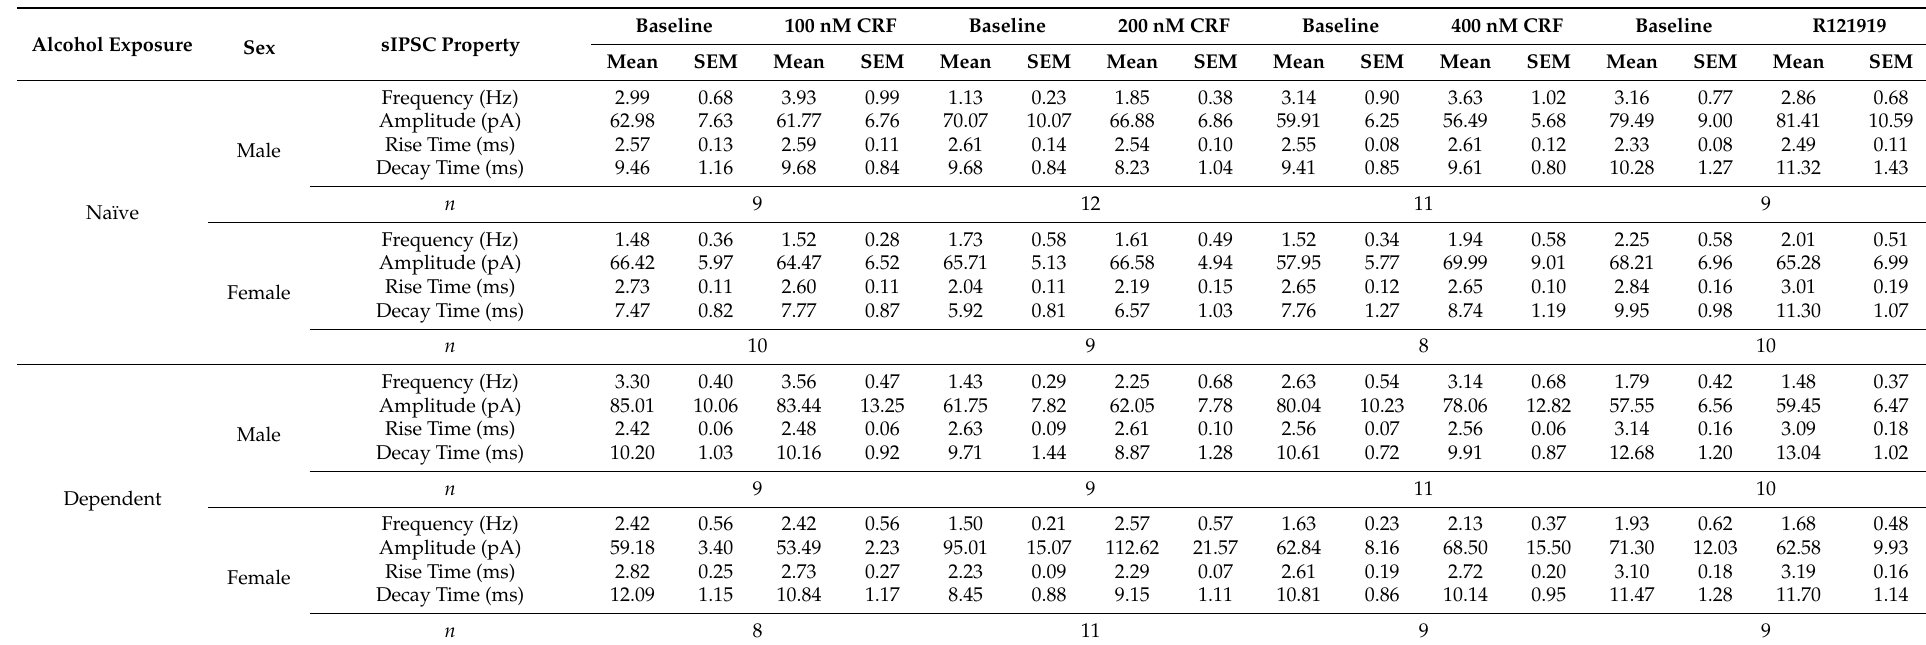
Table A1. Raw value group averages of each spontaneous inhibitory postsynaptic current (sIPSC) parameter